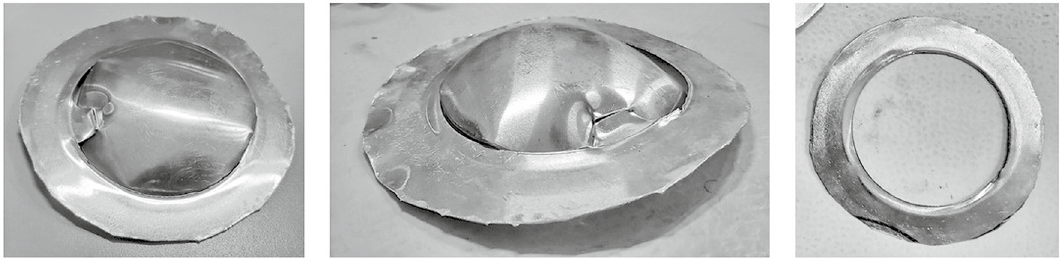
ing ring after the bulged loaded section was entirely removed by the HP diaphragm rupturing when increasing MPS pressure